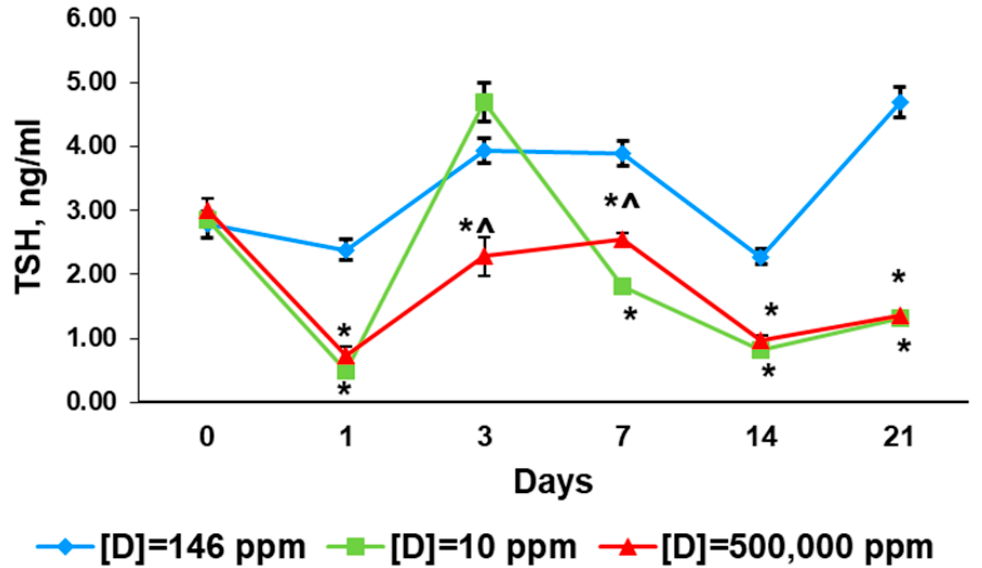
Figure 4. Thyroid-stimulating hormone concentrations in the rats that consumed water with modified deuterium content for 21 days. Data are shown as mean ± S.E.M.; p < 0.05 compared to the control (*), and to the rats that consumed water with [D] = 10 ppm (^).